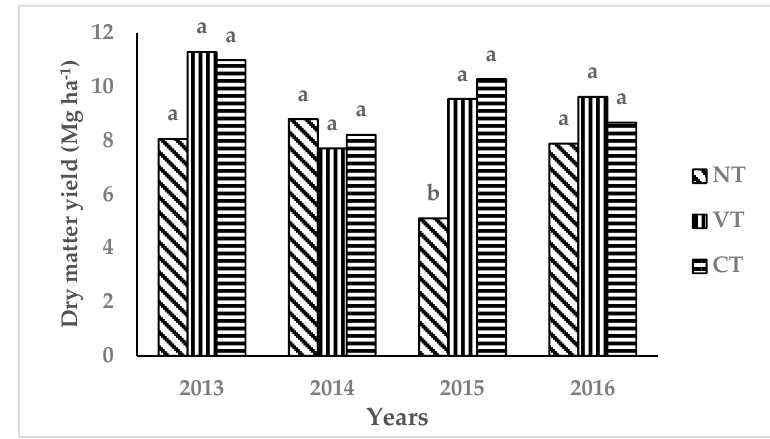
Figure 9. Dry matter yield of oats under the different tillage systems. Mean values with the same letter in the same year are not significantly different (Tukey α ≤ 0.05).